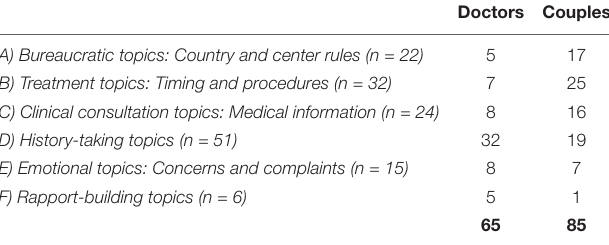
TABLE 6 | Topics connected to the strong types of misunderstandings ( n =